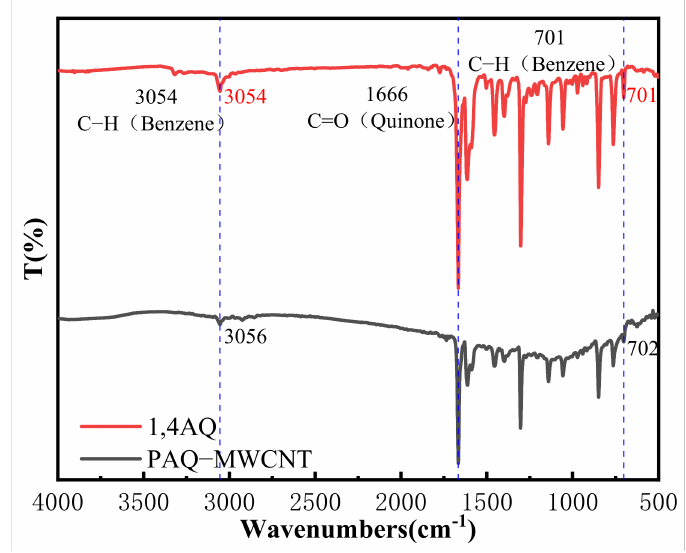
Figure 5. FTIR spectra of 1,4-AQ and PAQ/MWCNTs